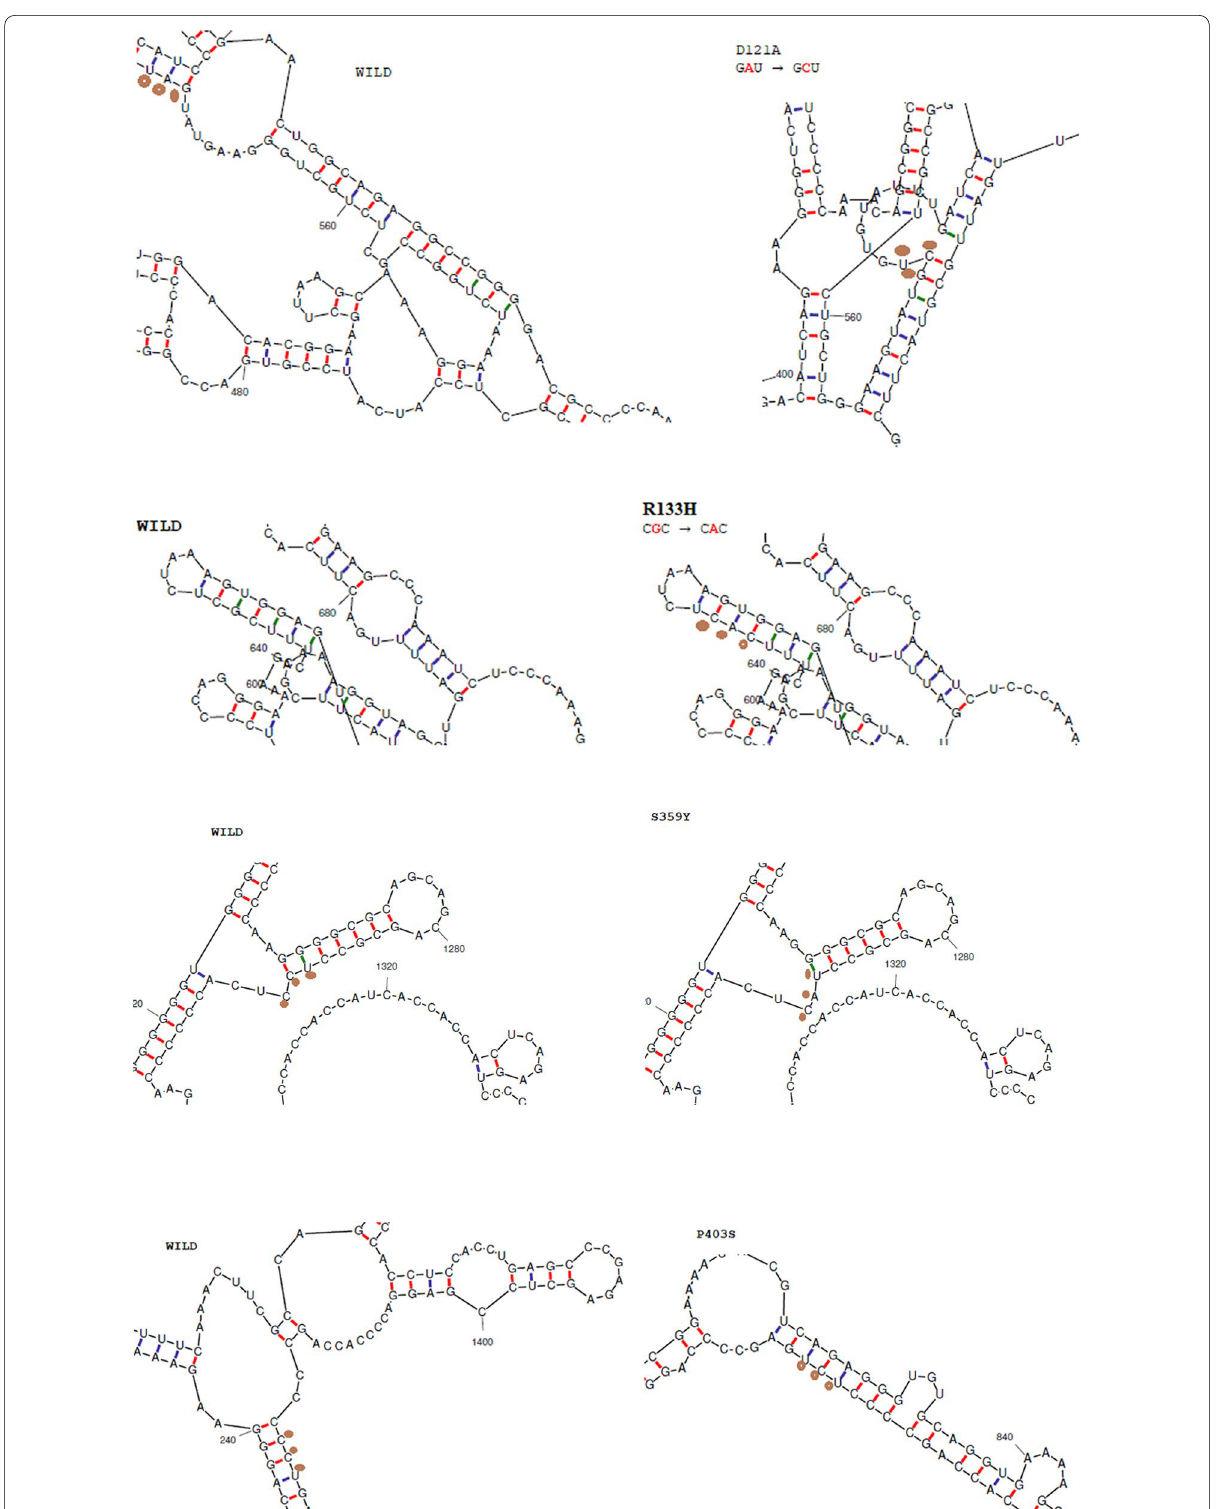
Fig. 4 Differences in mRNA folding between wild and mutant